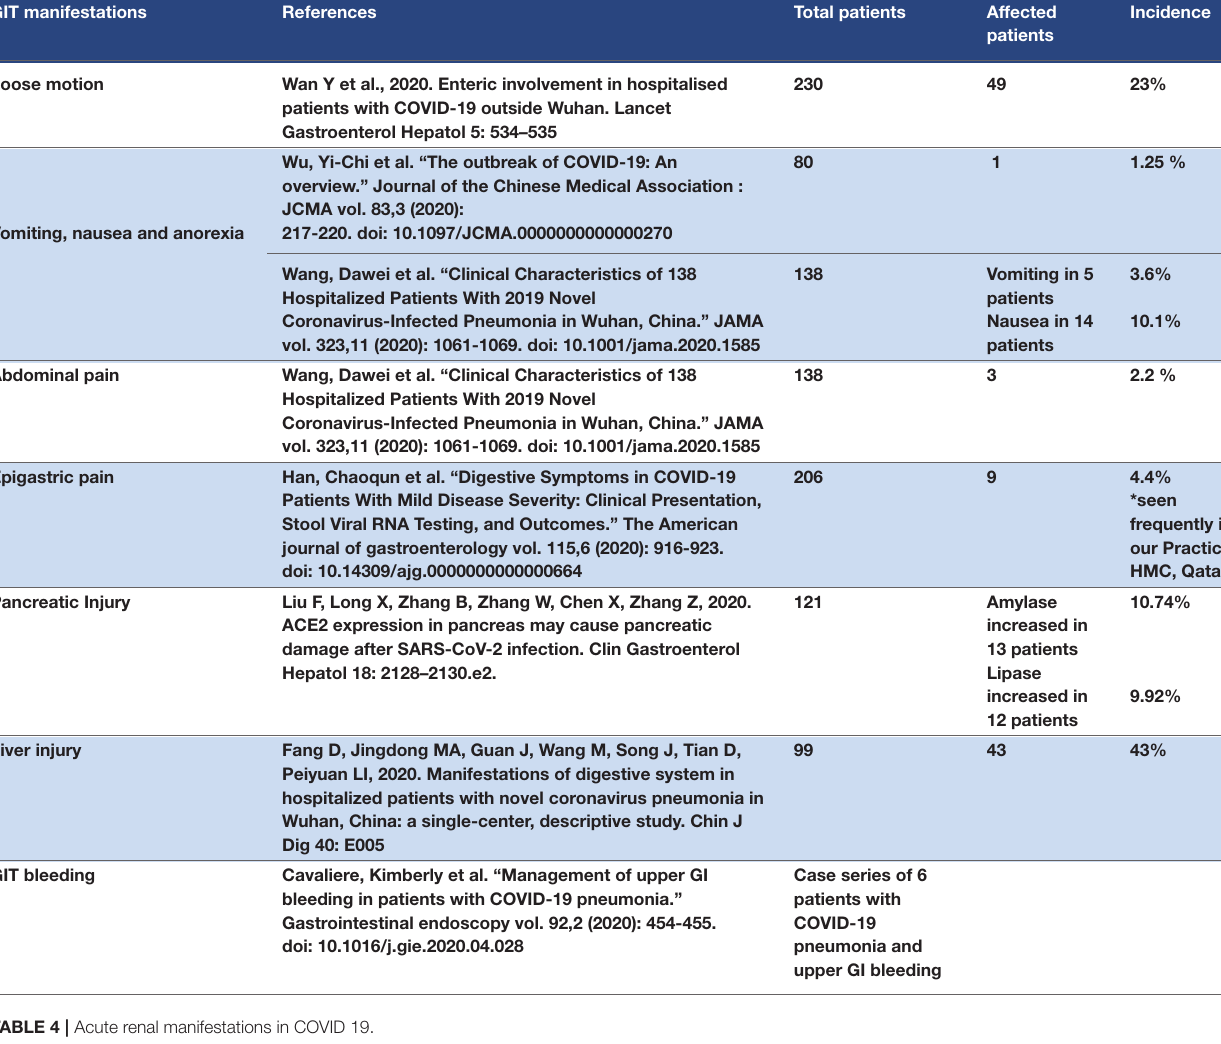
TABLE 3 | GIT manifestations.